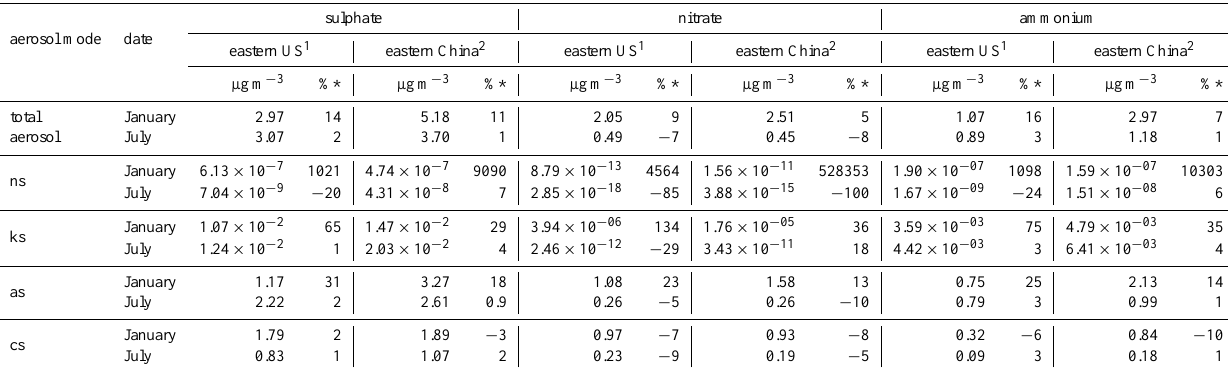
Fig. 7. Simulated aerosol nitrate concentration (µgm − 3 ) near the surface for the mean annual (upper panels), boreal winter (January, middle panels) and summer (July, lower panels) conditions and relative changes (in %, right panels) due to HONO enhancement in the model. Table 3. Contributions of the different aerosol modes to the simulated aerosol mean sulphate, nitrate and ammonium concentrations and their relative enhancement as a result of simulating realistic HONO